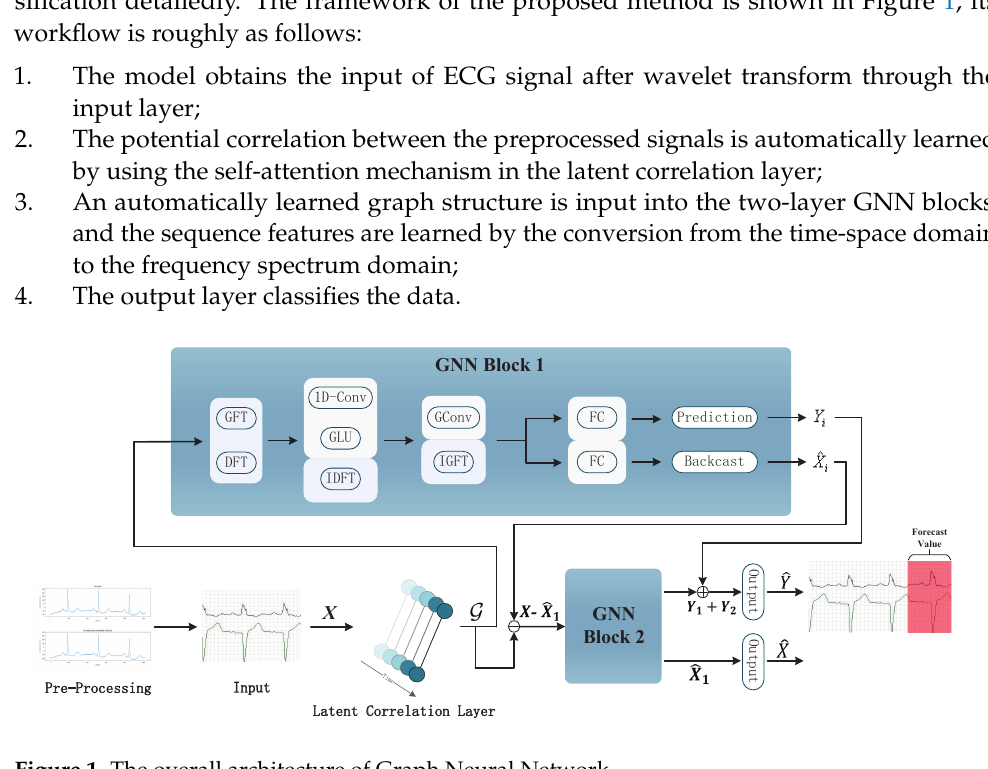
Figure 1. The overall architecture of Graph Neural